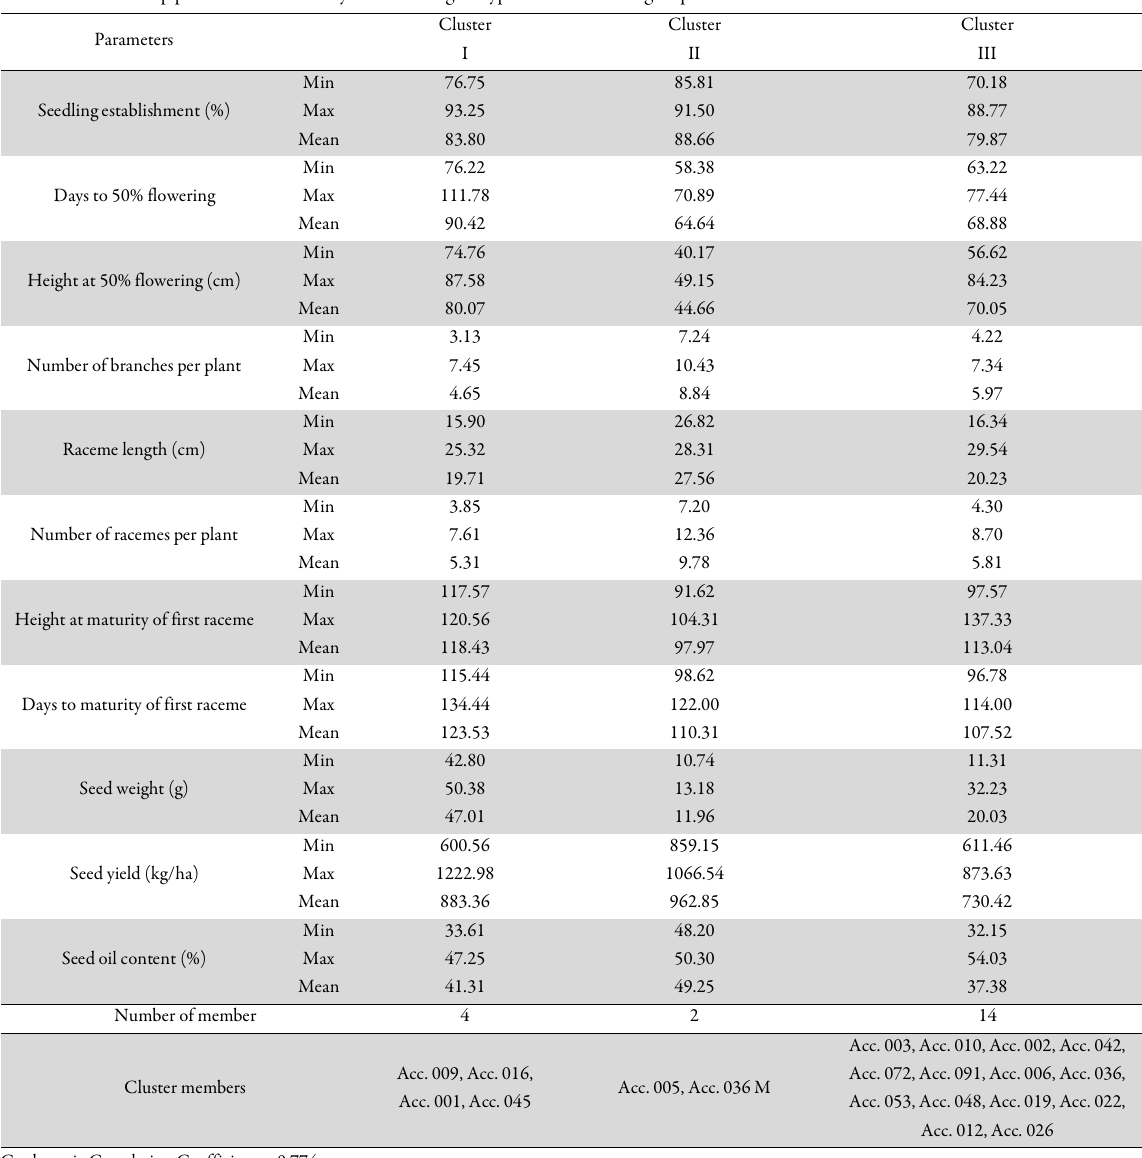
Table 4. Membership performance summary of 20 castor genotypes in three cluster groups